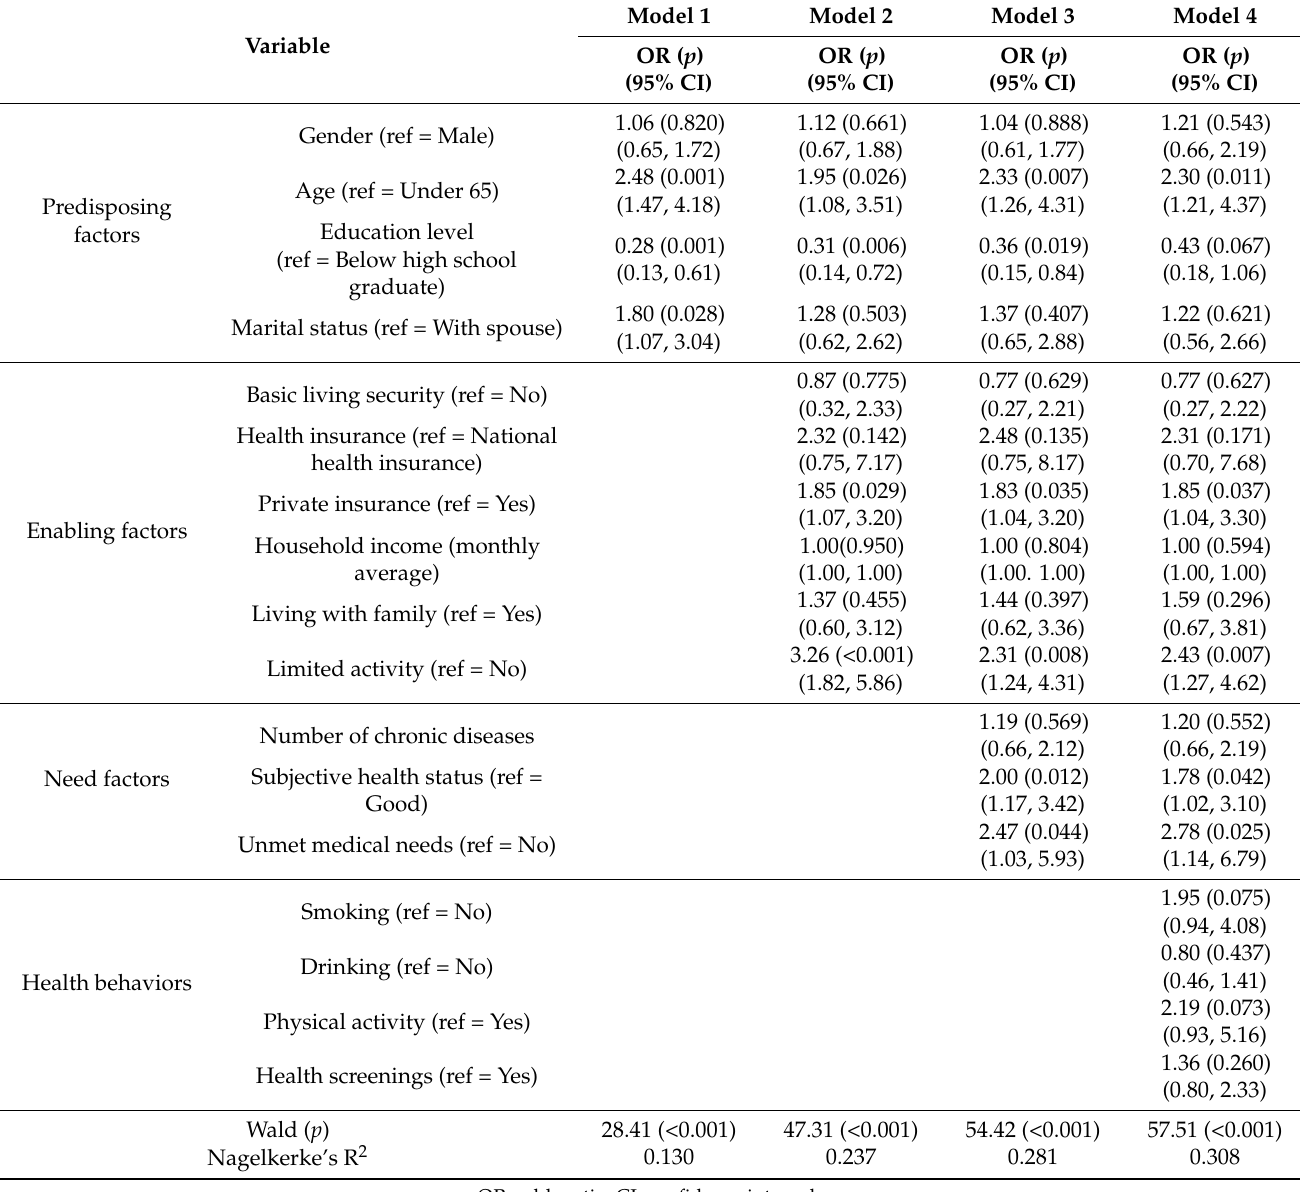
Table 2. Factors affecting mobility dimension of health-related quality of life in patients with multimorbidity according to Andersen’s model (South Korea,